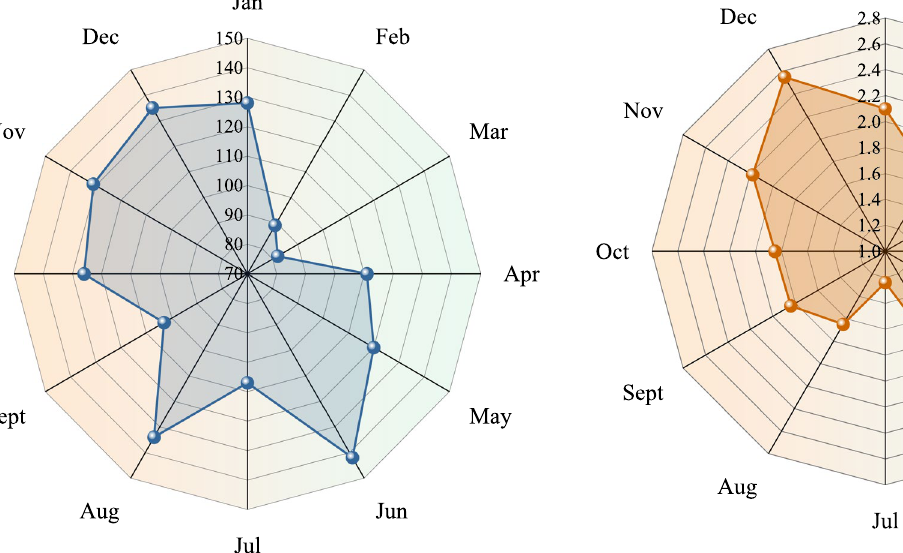
Fig. 12 The average number of deaths in different months from 2017 to